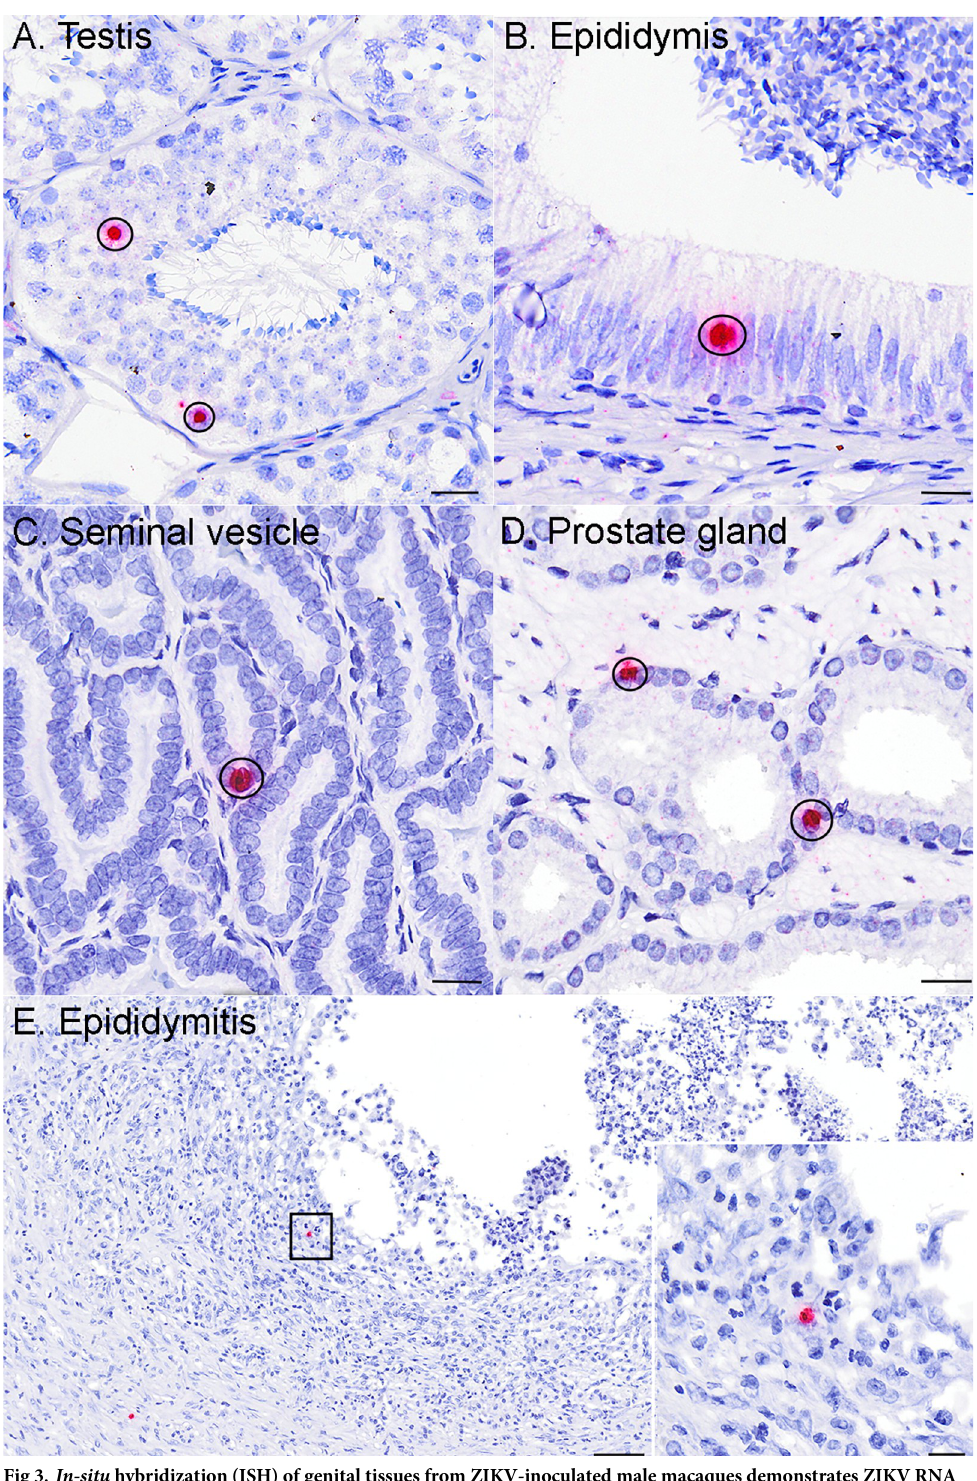
Fig 3. In-situ hybridization (ISH) of genital tissues from ZIKV-inoculated male macaques demonstrates ZIKV RNA in the testis, epididymis, seminal vesicle, and prostate gland. Photomicrographs of tissues from ZIKV-inoculated males after ISH where positive cells exhibit an intracytoplasmic/perinuclear red signal (circled). See Fig 7 for normal histology of testis, epididymis, seminal vesicle, and prostate gland. A.) Within the testis ZIKV RNA localized most frequently to sperm precursors, including germ cells, 1 o /2 o spermatocytes (circled), less frequently to Sertoli cells, and rarely to